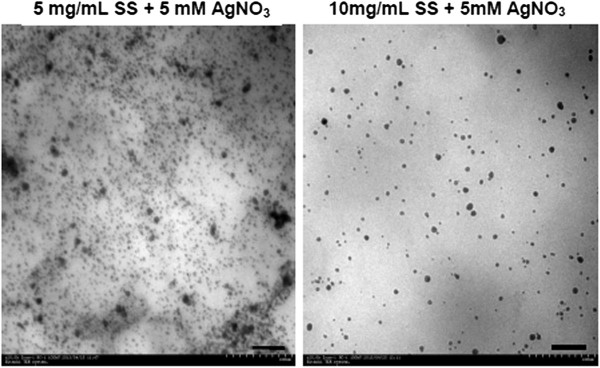
Morphology of SS-capped AgNPs synthesized from SS and AgNO3 at pH 11, observed on TEM. Scale bar = 1 μm.